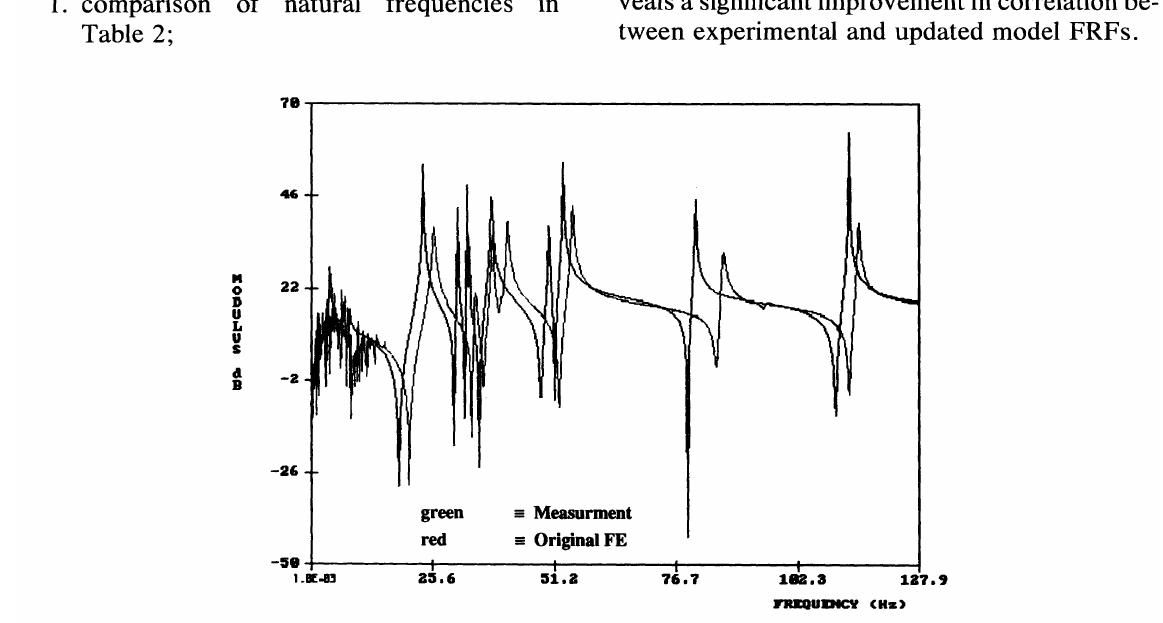
FIGURE 4 Measured and original FE point FRFs